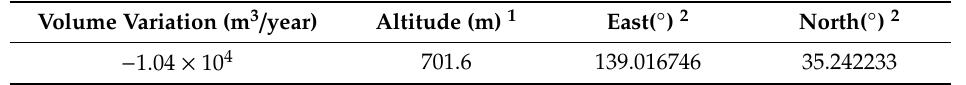
Table 2. Estimated parameters of the point pressure source beneath the area of subsidence to the west of Owakudani.